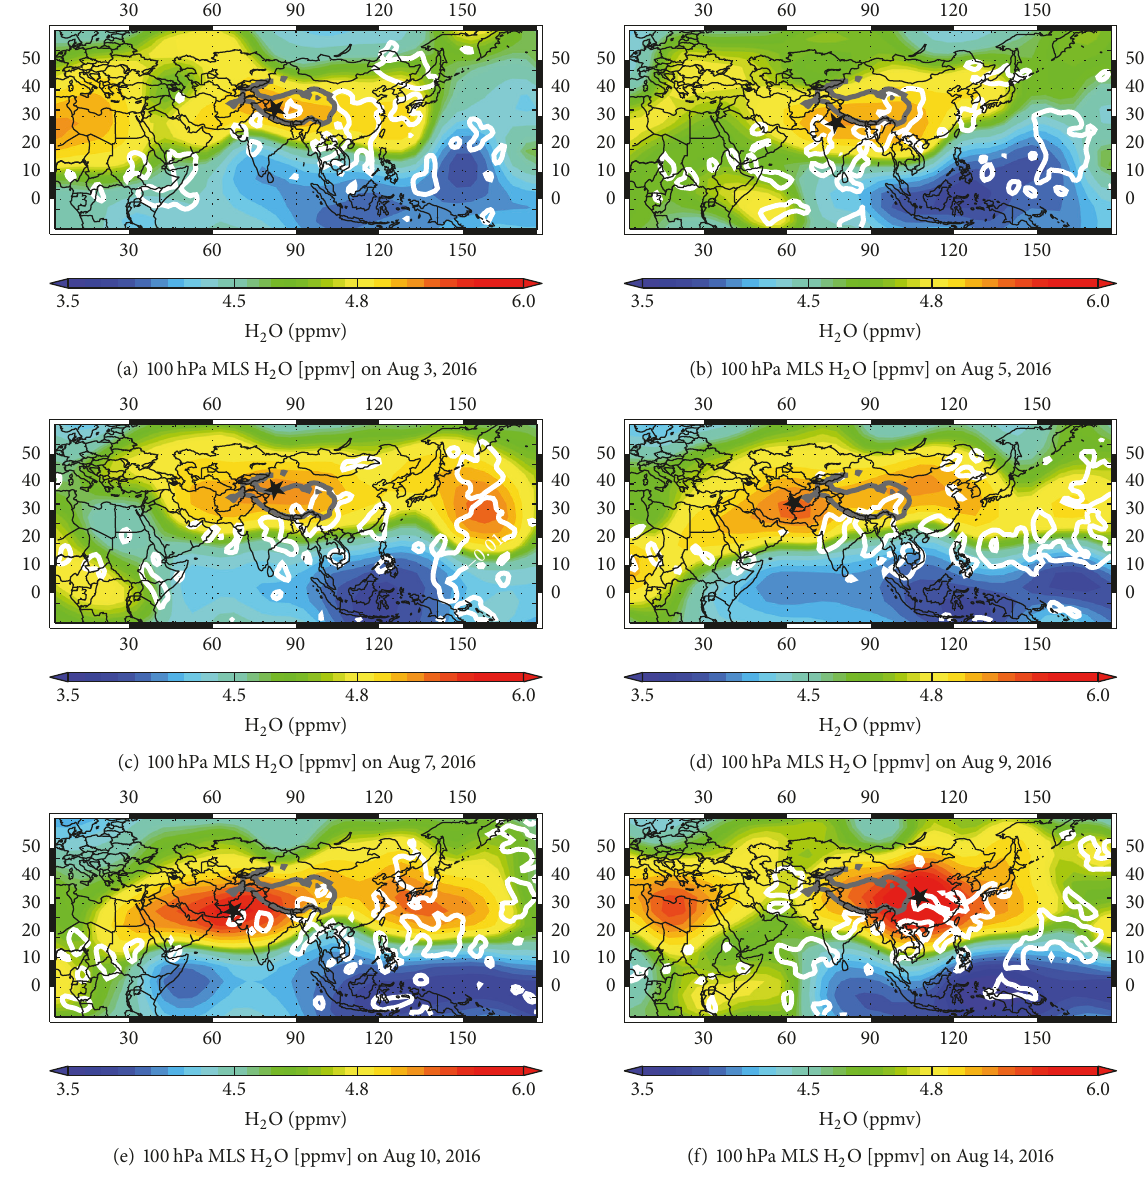
Figure 5: The same as Figure 3, but for MLS H 2 O at